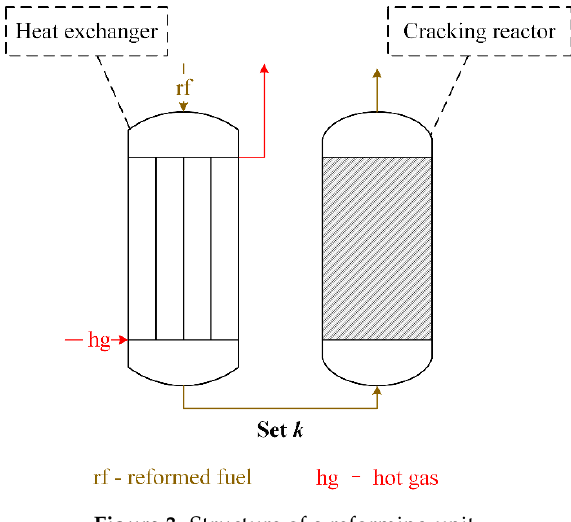
Figure 3. Structure of a reforming unit.